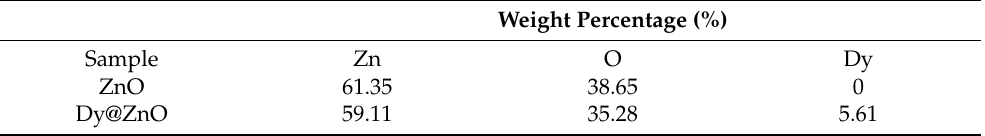
Table 1. The weight percentage of elements in pure and Dy-doped ZnO thin films.